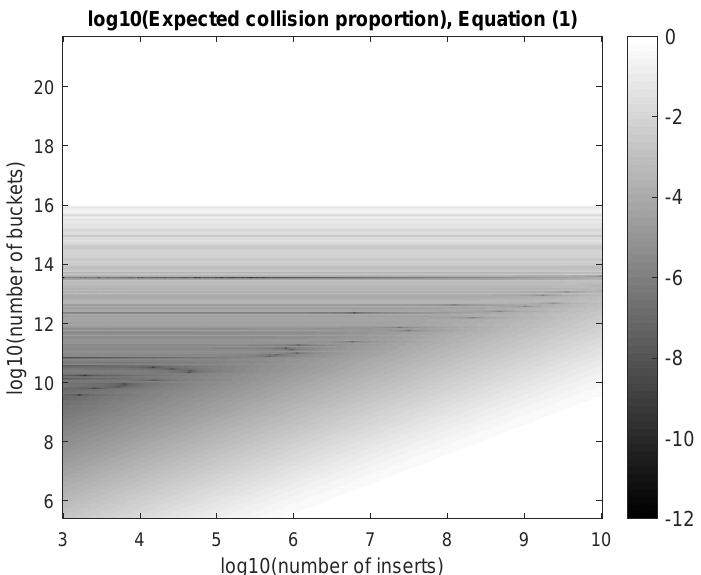
(cid:104) (cid:105) ( E Y ( n , m ) / n ) (using (1)) in Matlab R2019a as a 10 ( n ) ≥ 3, numerical 10 ( m ) as low as 10